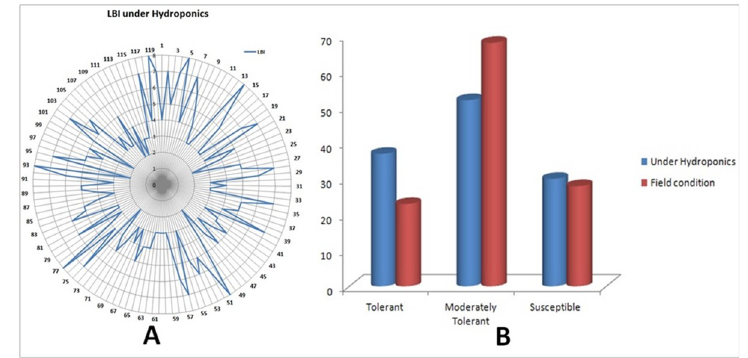
Fig 1. Leaf bronzing index of the 119 germplasm lines. (A) LBI of the 119 germplasm lines under hydroponics condition; (B) Frequency distribution of the LBI in the 119 germplasm lines under field and hydroponics